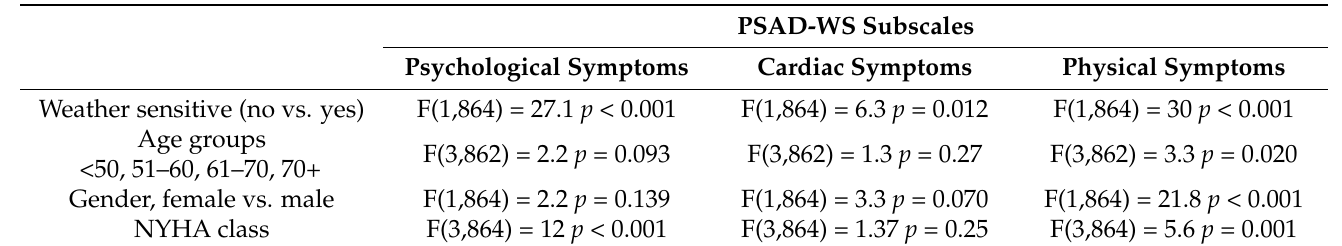
Table 2. Analysis of variance by PSAD-WS subscales (F statistic).